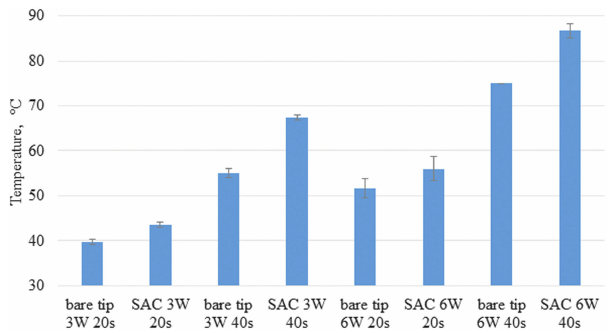
Fig. 3. The temperature values of the bacterial suspension at various irradiation modes.